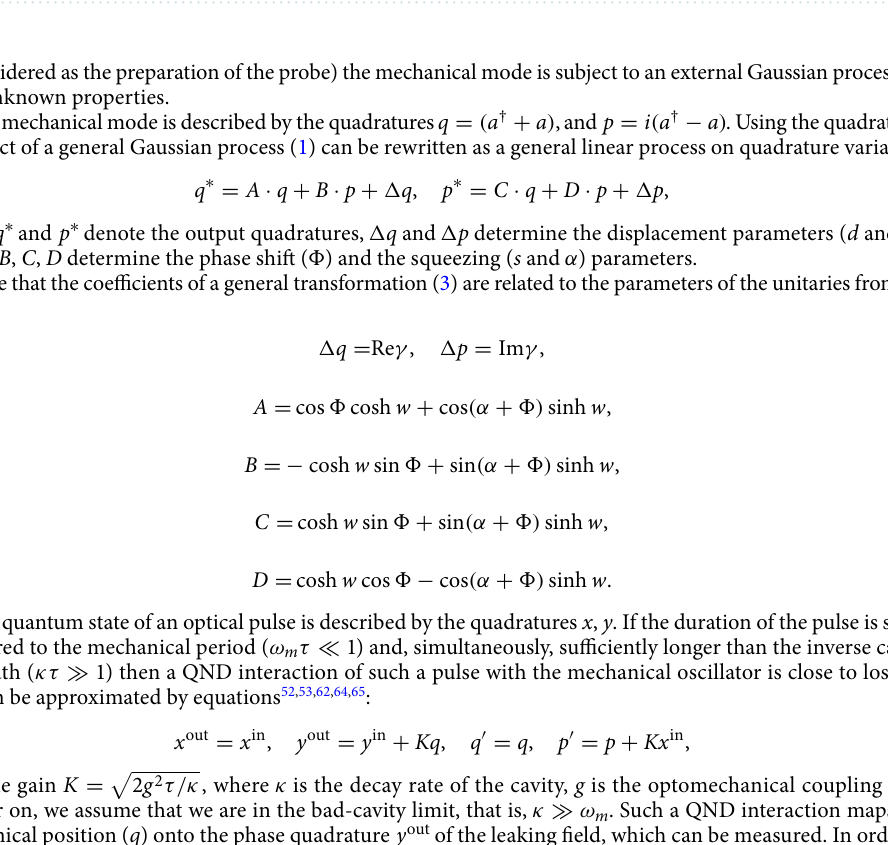
Table 1. Experimental parameters for short-pulsed optomechanical experiments inspired by Refs. 52–55,57,60,66